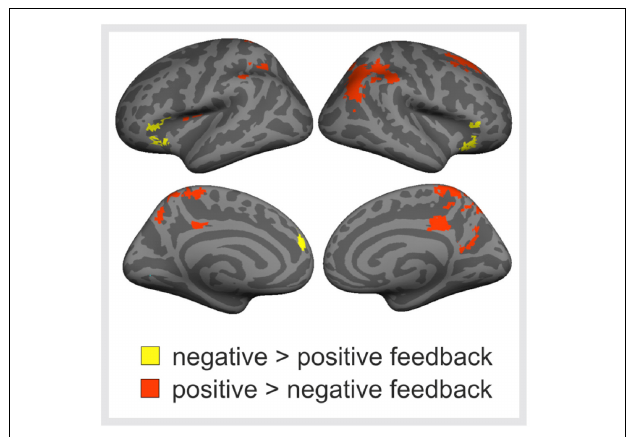
FIGURE 4 | Brain responses to negative vs. positive peer feedback. Brain regions showing significantly higher activity in response to negative than positive peer feedback (yellow areas), and vice versa (red areas). Cluster-level family-wise error corrected p < 0.05, cluster size > 100